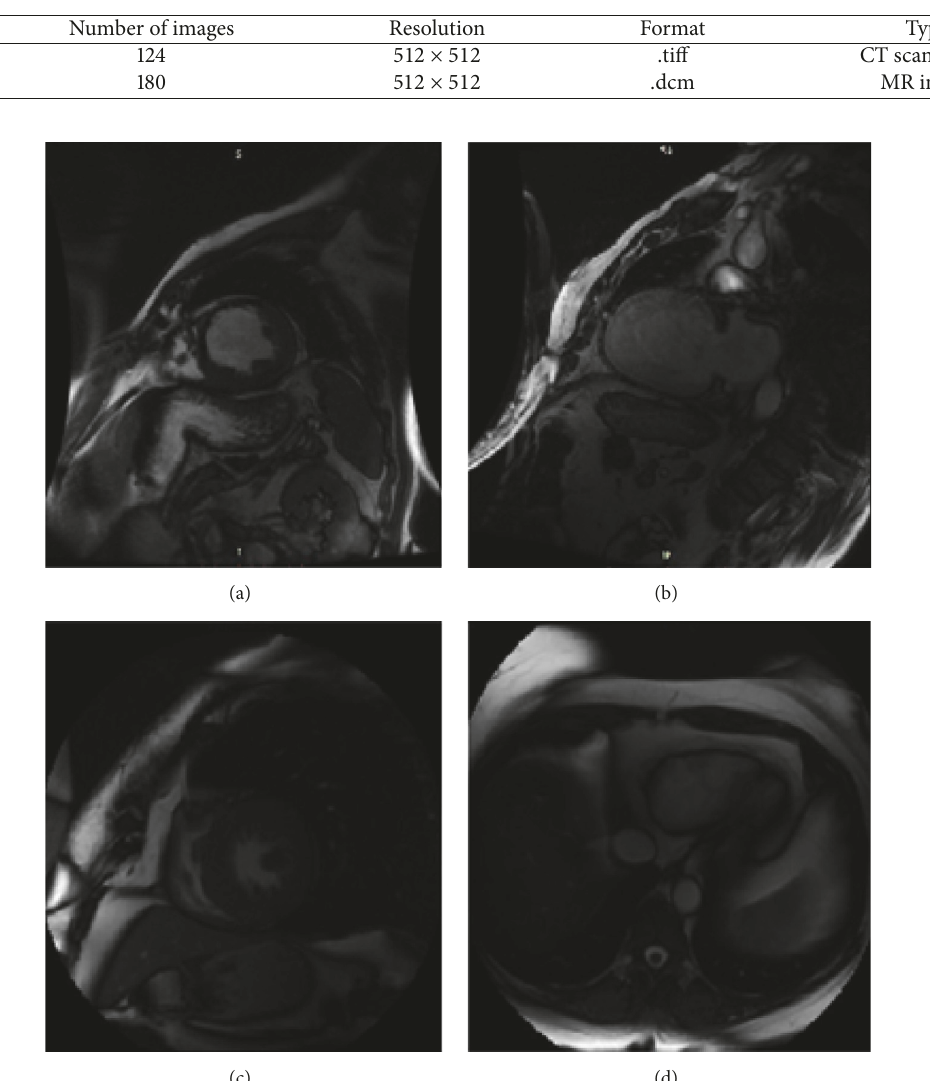
Figure 4: MR images of patients with heart condition as (a) heart failure with infarcts; (b) heart failure without infarcts; (c) hypertrophy; (d)